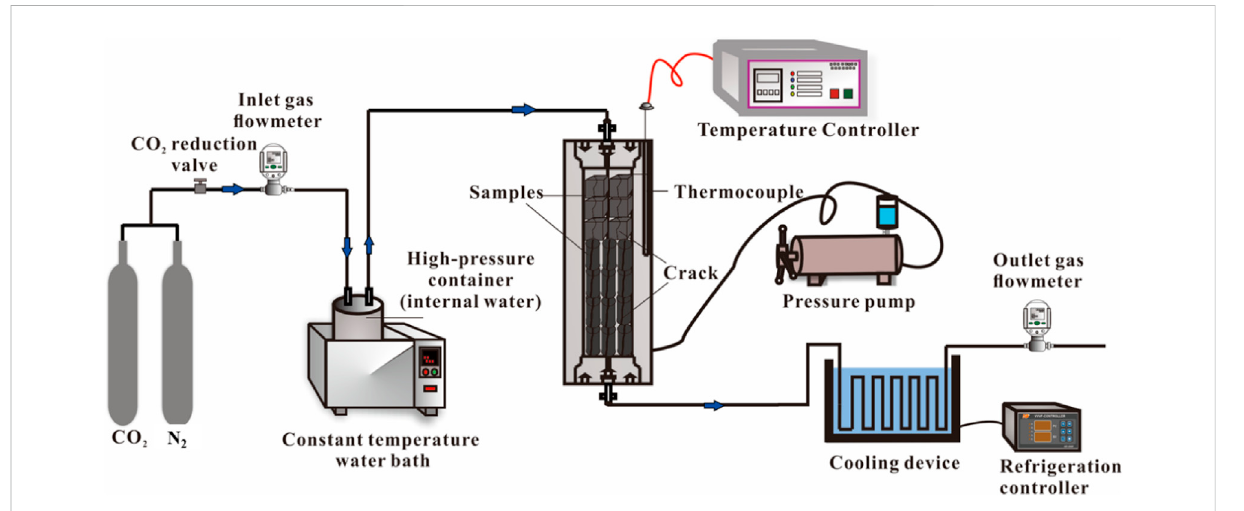
FIGURE 1 Schematic of the cement self-healing equipment.